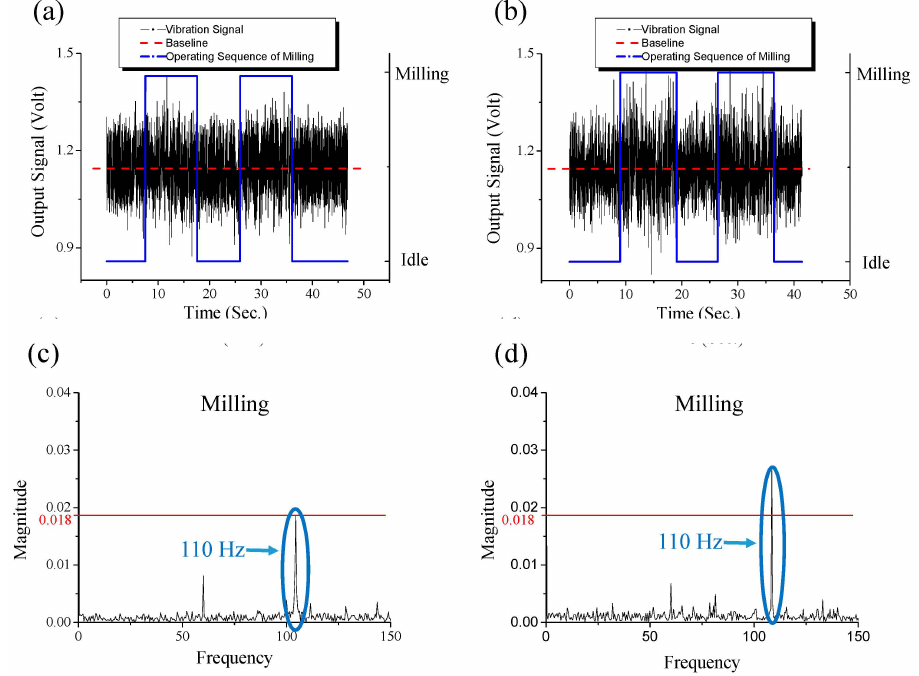
Figure 9. The time-domain z-axial vibrational signals at ( a ) critical point; after 20 min milling; ( b ) the last point before cutter-breakage after 25 min of milling. The corresponding frequency-domain signals in “milling” status at ( c ) critical point; after 20 min milling, ( d ) the last point before cutter-breakage; after 25 min